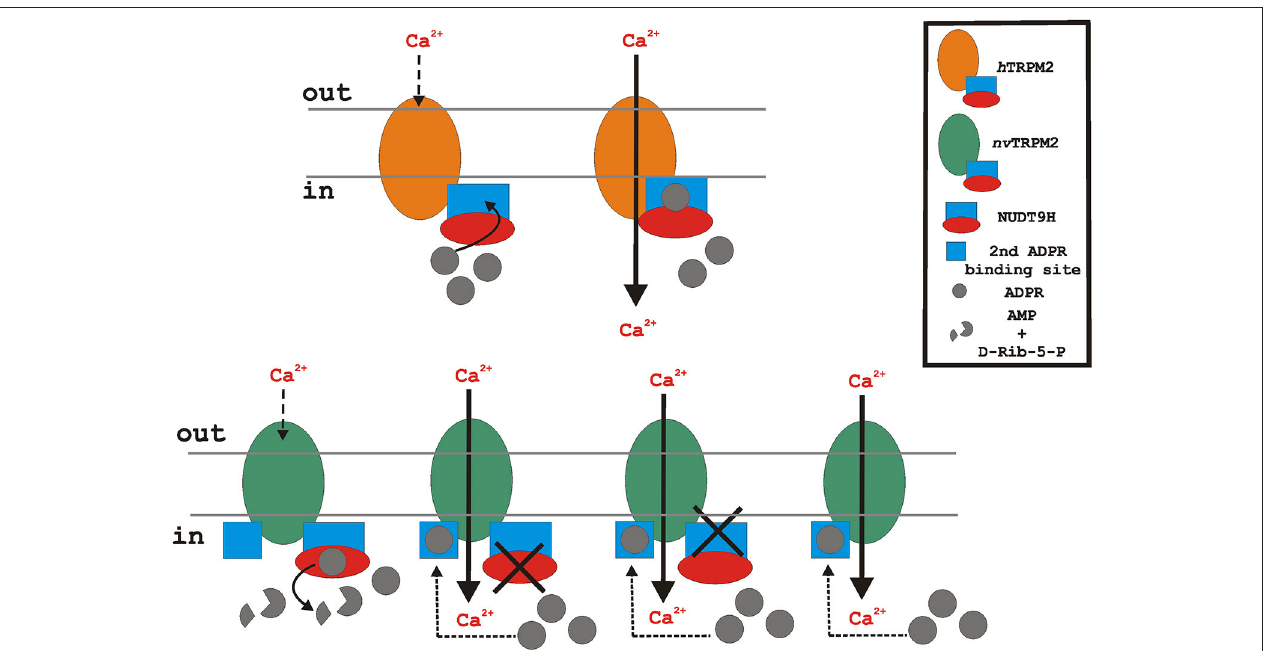
FIGURE 3 | Putative functional role of the endogenous NUDT9H domain of the TRPM2 orthologs during oxidative stress (stimulation with H 2 O 2 ). Oxidative stress leads to intracellular accumulation of ADPR. In the case of h TRPM2 (upper), ADPR binds to the cytosolic NUDT9H domain (lacking significant ADPRase activity) and initiates channel activation. In contrast, nv TRPM2 (lower, left) exhibits full catalytic activity. Therefore, ADPR is degraded and the cytosolic concentration of ADPR remains too low to initiate channel activation. However, when the enzymatic function of the NUDT9H domain of nv TRPM2 is disrupted due to point mutations, interfering either with binding or with cleavage of ADPR, or due to the deletion of the entire NUDT9H, the accumulated intracellular ADPR enables channel gating via a second interaction site. The cartoon reflects the experimental situation of nv TRPM2 over-expression in mammalian cells (HEK-293) with no external ADPR added to the cytosol. Note that for the proper function of nv TRPM2 in their native environment, a cellular mechanism is required that controls the catalytic activity of the NUDT9H domain and thereby enables ADPR-dependent gating of nv